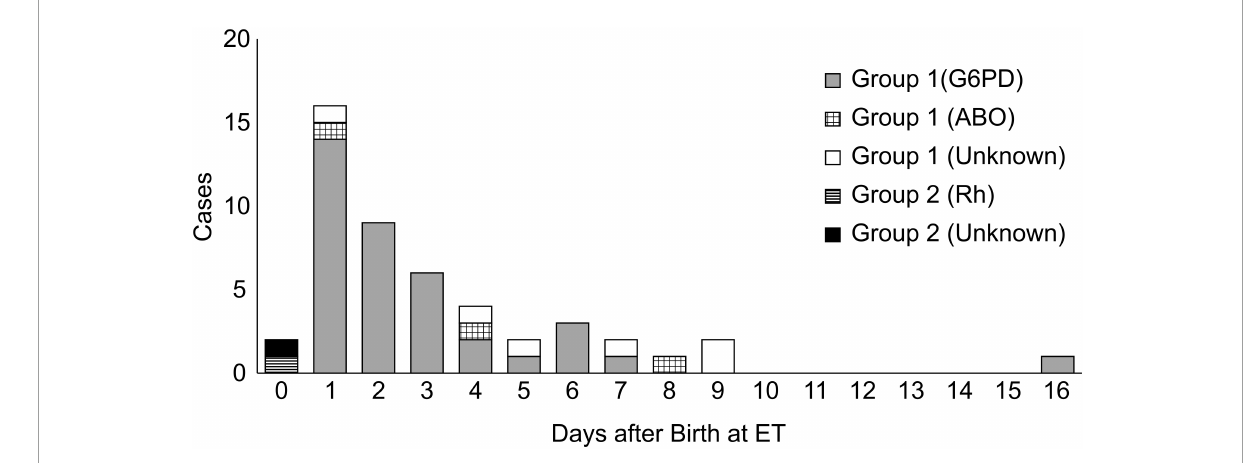
FIGURE3 The number of cases that required ET according to the days after birth and causes of hyperbilirubinemia.